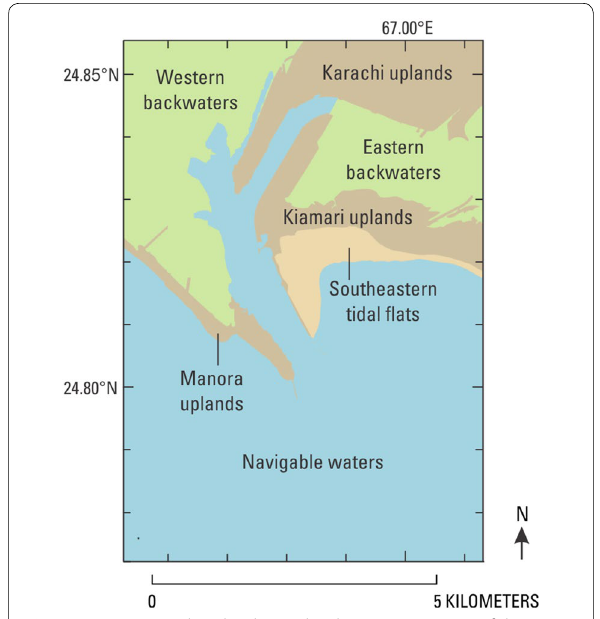
Fig. 4 Areas interpolated independently in construction of